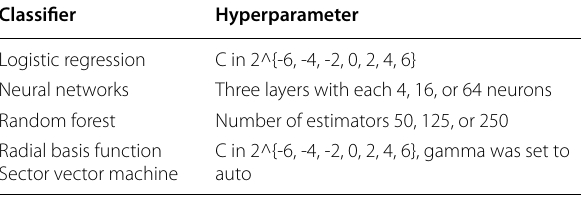
Table 3 List of hyperparameters tuned during cross-validation Classifier Hyperparameter Logistic regression Neural networks Three layers with each 4, 16, or 64 neurons Random forest Radial basis function Sector vector The remaining hyperparameters were left at their default